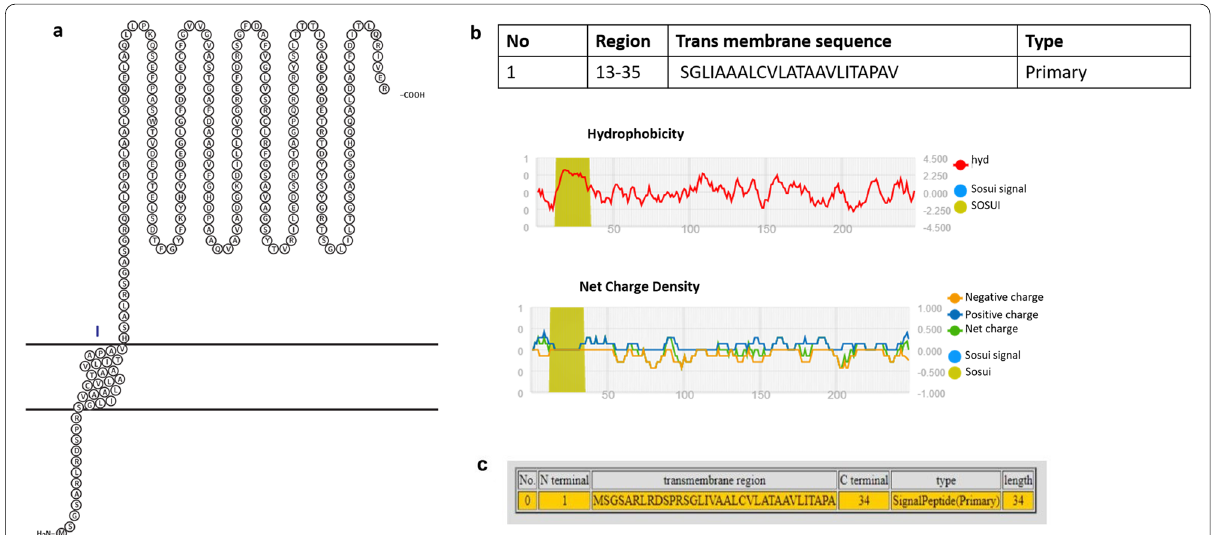
Fig. 1 Cellular localization image of NHP1 protein showing a signal peptide with transmembrane structure using the server SOSUI. a N-terminal, transmembrane, and C-terminal domains of NHP1. b NHP1 hydropathy and charge plot. c Transmembrane sequence of NHP1